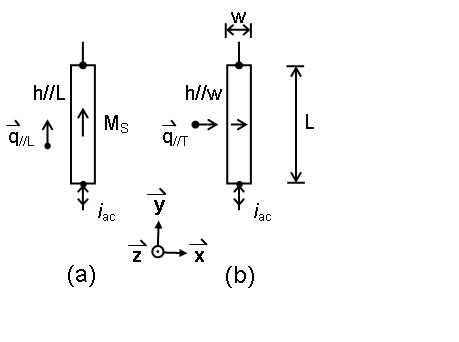
Two Co40Fe40B20 film samples. L is the length and w the width. iac is the ac current sent through each sample.  is the saturation magnetization and  is the deposition field.  and  are the in-plane spin-wave wave vectors. (a) The ||L case and (b) the ||w case.